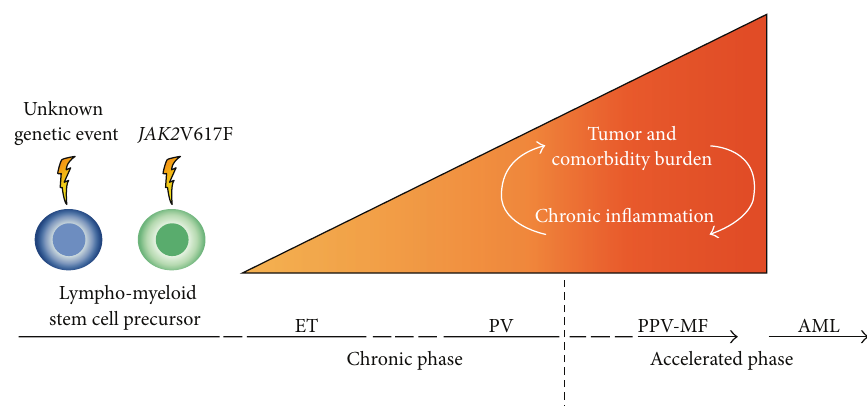
Figure 3: Chronic inflammation as the driving force for clonal evolution in MPNs. Tumor burden and comorbidity burden are illustrated for patients with JAK2 V617F positive MPNs. Comorbidity burden increases from early disease stage (ET/PV) to the accelerated phase with myelofibrotic and leukemic transformation. With permission: H. C. Hasselbalch [12]. AML: acute myeloid leukemia; ET: essential